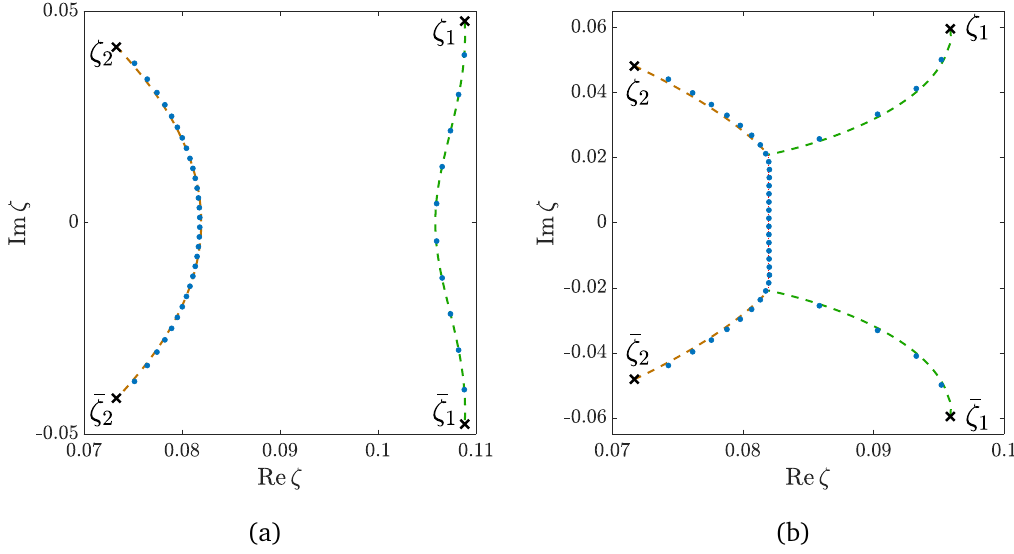
Figure 9: (Left) Comparison between the density contour (dashed line) of a classical two-cut solution (shown for the isotropic case ( δ = 0), with partial filling fractions ν = 0.02, ν = 0.06 and mode numbers n = 1, n = 2), obtained from reality con- 1 2 1 2 dition (6.3), and the corresponding numerical solution to Bethe equations (3.3) with = 10, M = 30, L = 500 and η = 0 (blue dots). (Right) Comparison between M 1 2 the classical contour (dashed line) (shown for the isotropic case ( δ = 0), with partial = 0.025, ν = 0.075 and mode numbers n = 1, n = 2), ob- filling fractions ν 1 2 1 2 tained from reality condition (6.3), to the corresponding numerical solution to Bethe = 30, L = 400 and η = 0 (blue dots). The Bethe equations (3.3) with M 1 = 10, M 2 = 1 / ( L λ ) , same as in Fig. roots plotted are ζ j j